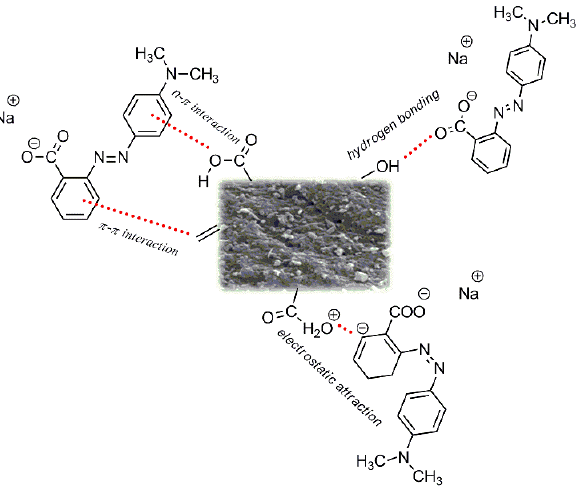
Figure 12. The adsorption mechanism of methyl red sodium salt by biocarbons obtained.